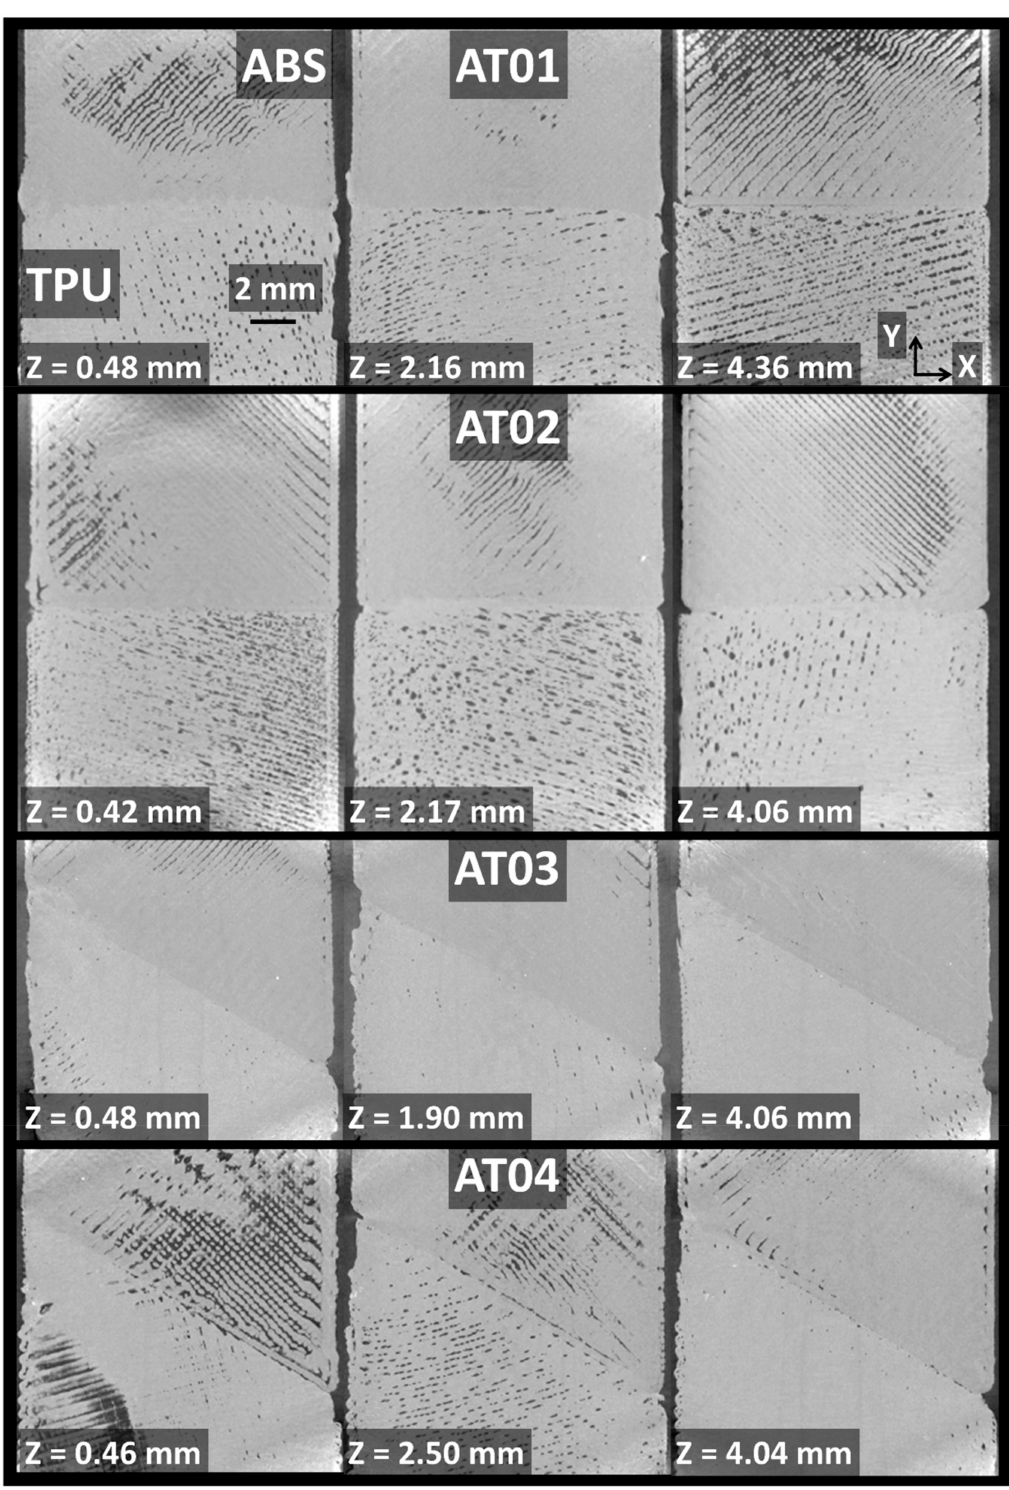
Figure 7. X–Y in-plane cross-section views (dimensions 10 mm × 10 mm) showing the porosity arrangement at different depth positions (Z) for all printed ABS/TPU